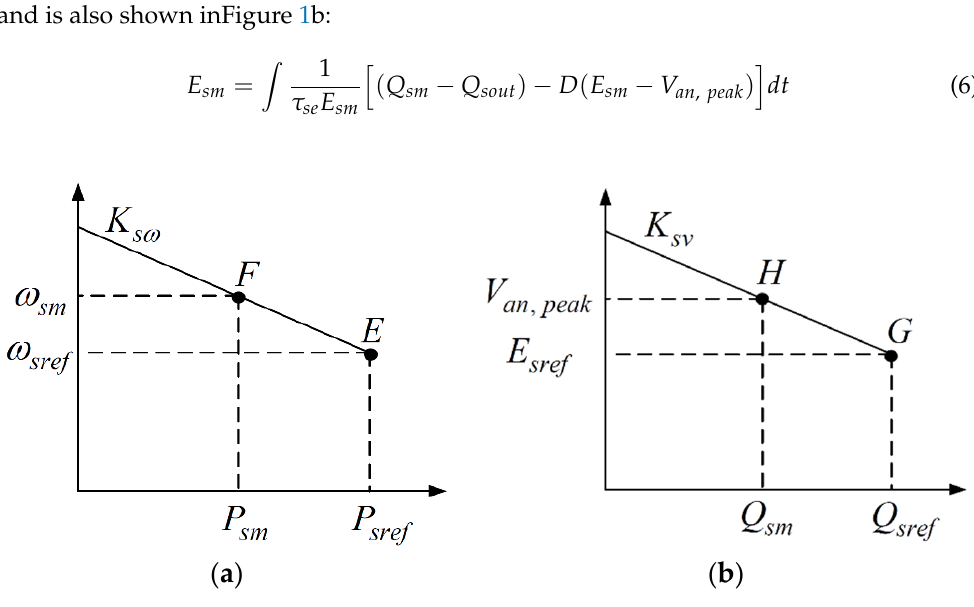
Figure 2. Droop control. ( a ) ω - P droop; ( b ) V - Q droop. The virtual rotor angle θ and the amplitude of virtual internal electromotive force E sm